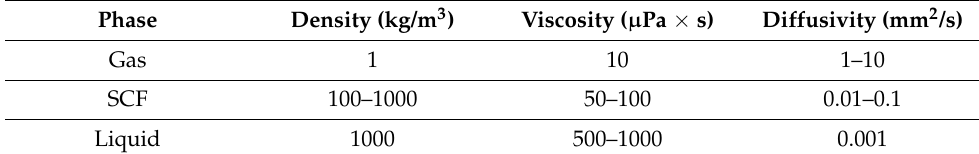
Table 1. Comparison of physical parameters in different physical states [1,2].